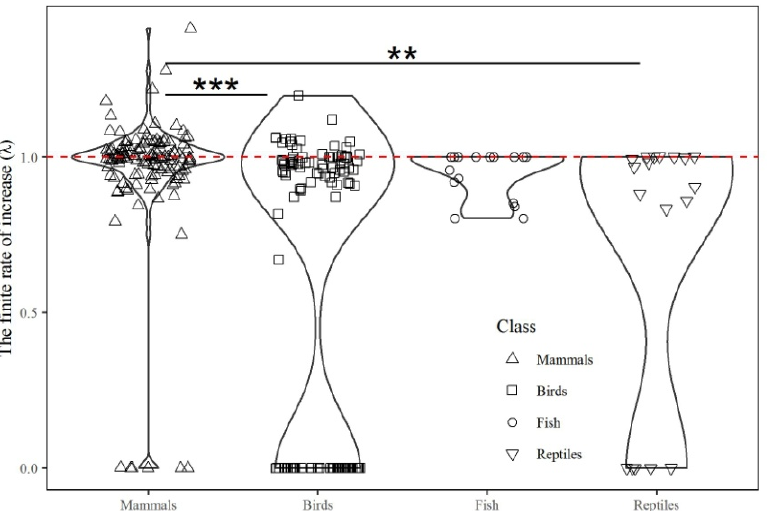
Figure 4. The finite rate of increase ( λ ) of each species imported into China, grouped by taxonomic class (*** p < 0.001; ** p < 0.01).